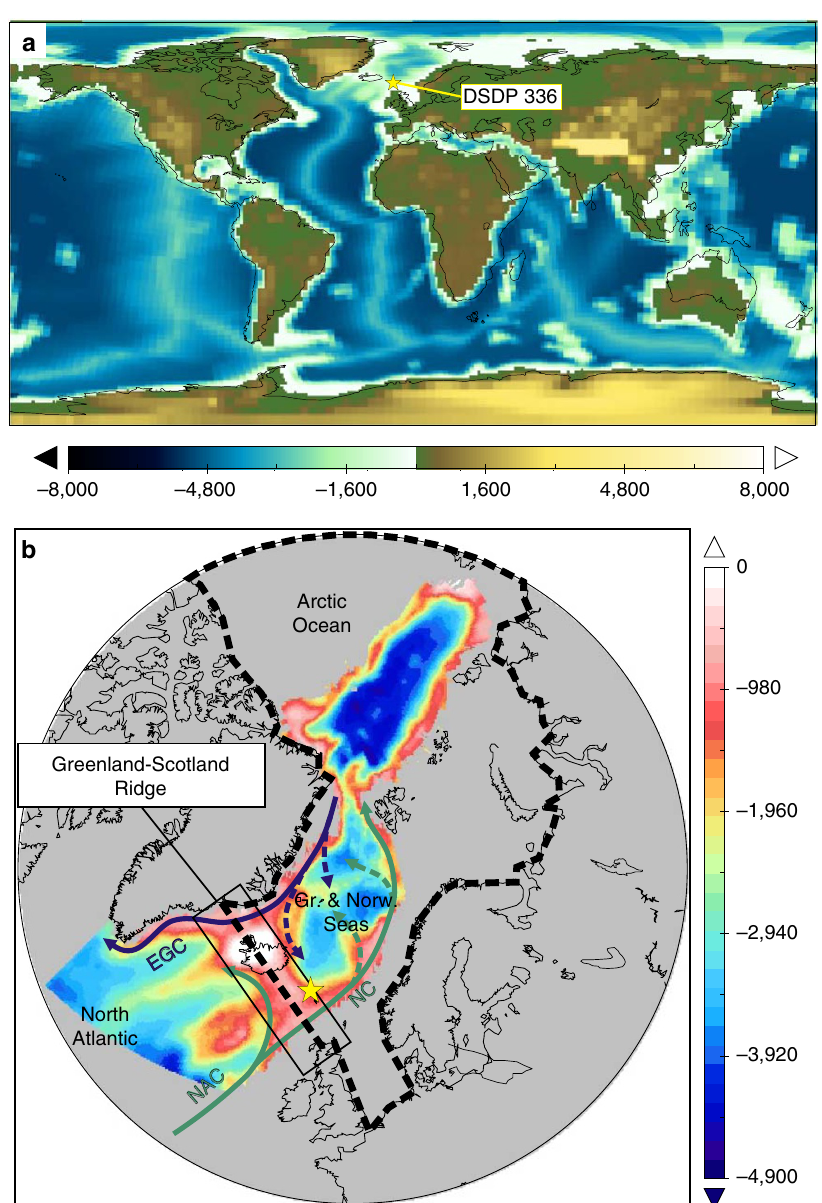
Figure 1 | Geographical settings of Miocene topography circa 20 to 15Ma. ( a ) Global compilation of Miocene geography 19 (elevation and depth in metres); ( b ) A high resolution (0.5 (cid:2) ; depth in metres) bathymetric dataset is embedded in the global setup comprising the northern North Atlantic, subpolar Arctic (Greenland and Norwegian Seas) and the Eurasian Basin in the Arctic Ocean 20 . The Arctic Ocean is defined by the central Arctic and the Greenland and Norwegian Seas as shown by the stippled lines. The schematic circulation shows pathways of the North Atlantic Current (NAC), the Norwegian Current (NC) and the East Greenland Current (EGC). The yellow star reflects the location of site 336 of the Deep Sea Drilling Project 21 at the northern flank of the